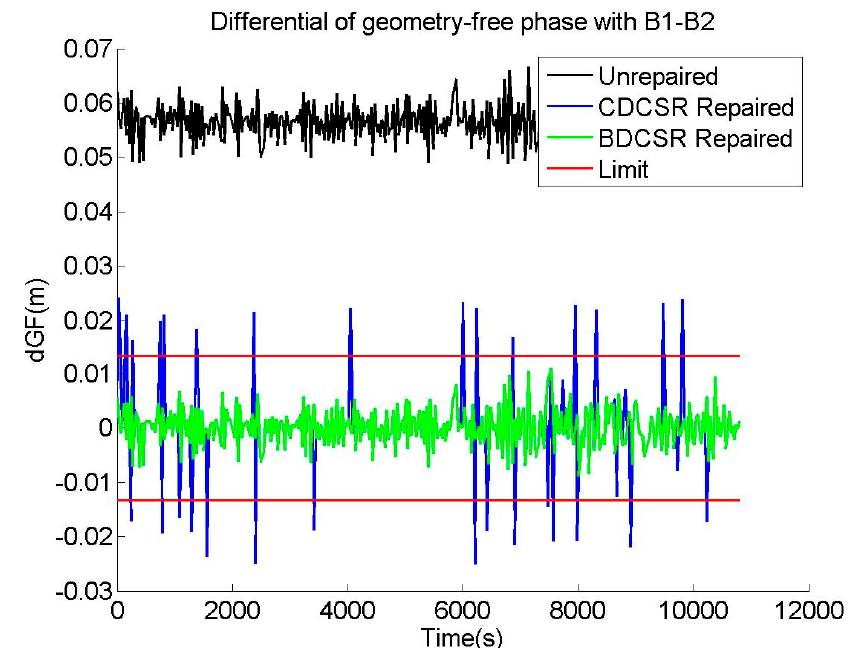
Figure 17. The differentials of geometry-free phases, provided by the unrepaired data and the repaired data with the BDCSR methodology and CDCSR in the case of normal pseudorange data and phase data with slips of (1,1) cycles on (B1,B2), where the observation data were collected by the CUT0 started from UTC 8 May 2016 00:00:00.